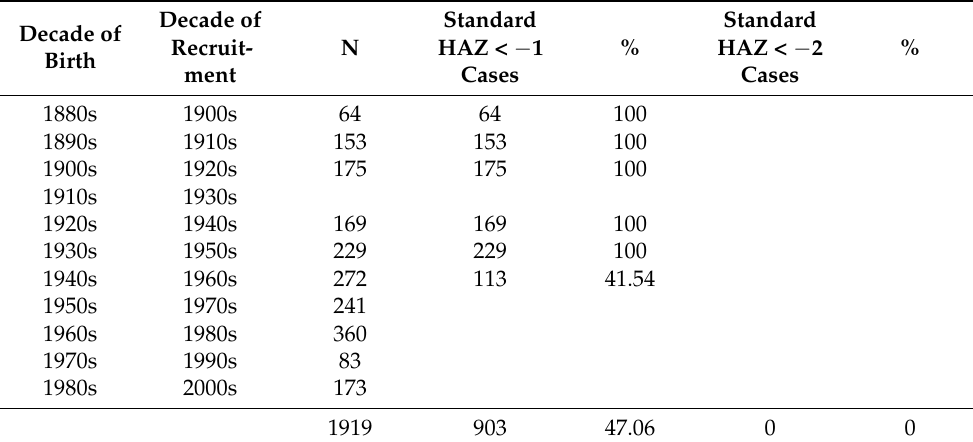
Table 4. Stunting rates according to the WHO (2007) by decade of birth/recruitment.